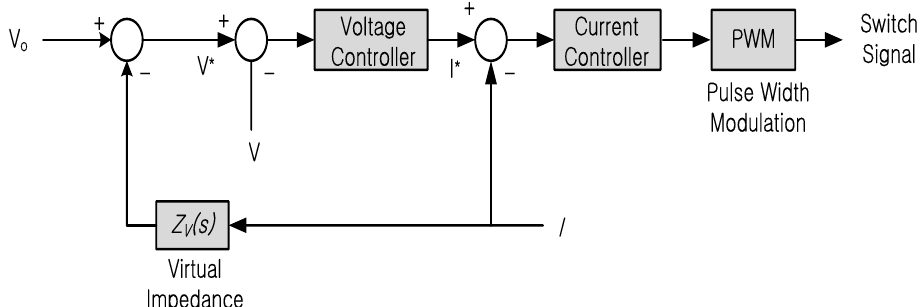
Figure 6. Block diagram of a virtual impedance-based power management.